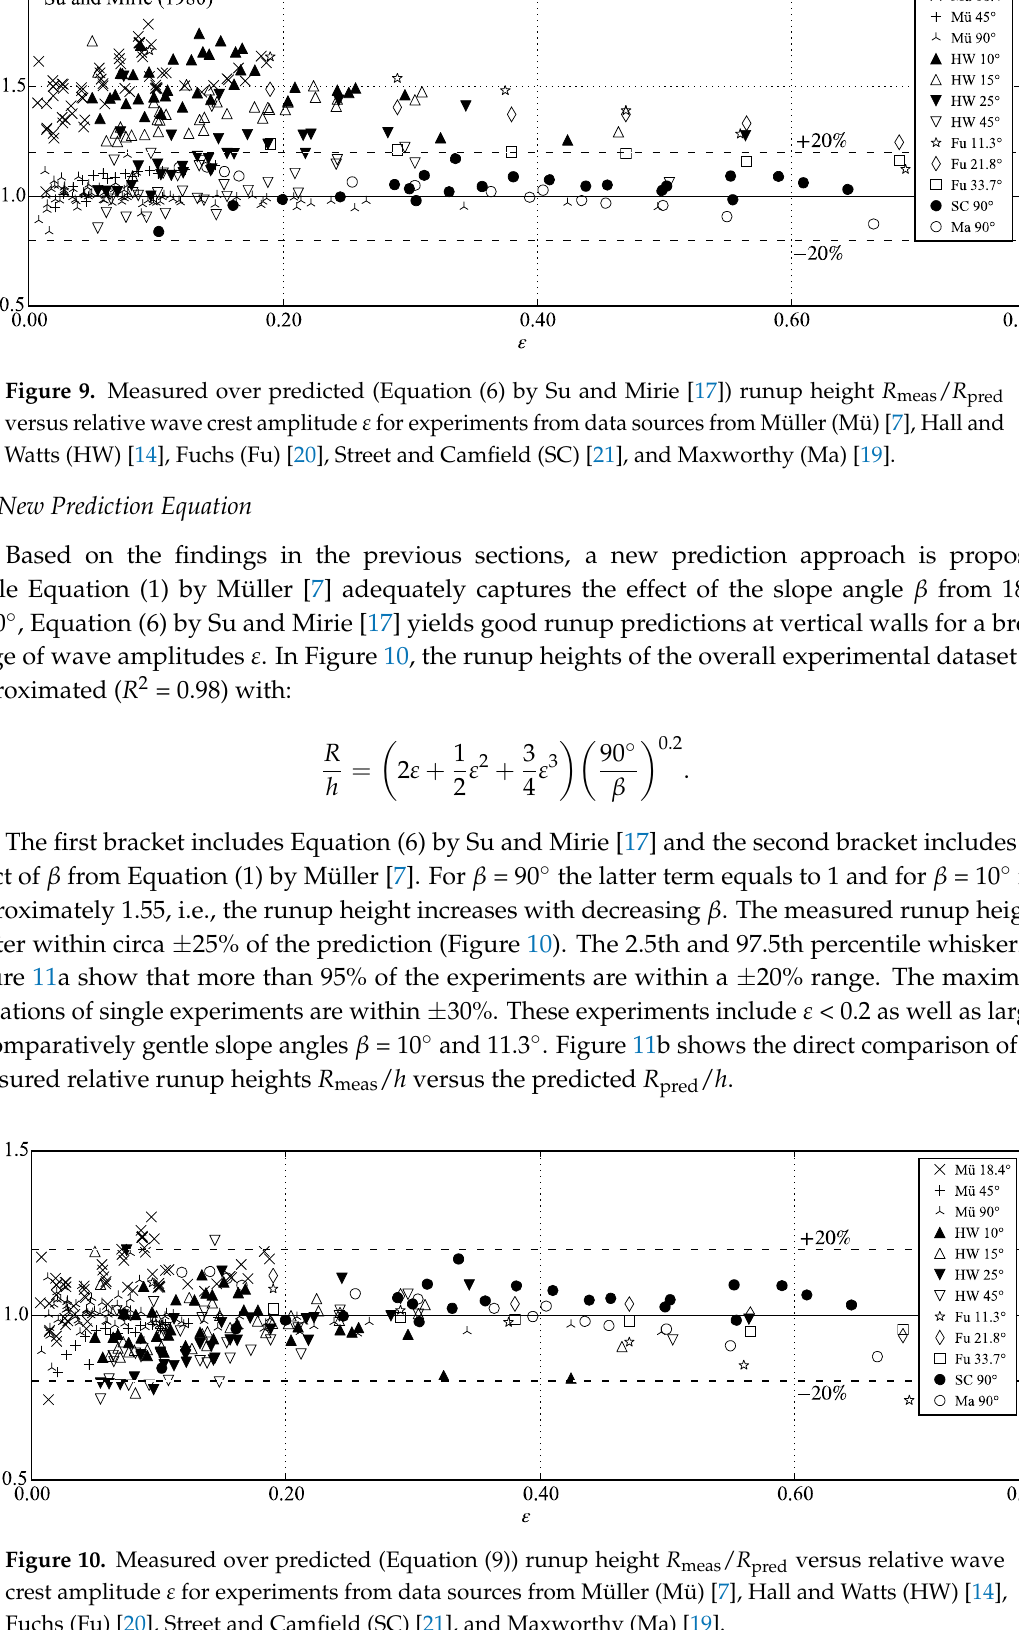
( a ) ( b ) Figure 11. ( a ) Histogram and boxplot with whiskers at 2.5th and 97.5th percentile of measured over predicted (Equation (9)) runup heights R meas / R pred and ( b ) measured versus predicted runup heights R over stillwater depth h of the overall dataset. As a simplified version of Equation (9), the following prediction equation for non‐breaking impulse and solitary wave runup on steep to vertical slopes is proposed ( R 2 = 0.98): 0.2 0.4 90 2          R e h . (10) The term 2 εe 0.4 ε in Equation (10) approximates Su and Mirie’s [17] Equation (6) by multiplying the minimum runup height of 2 ε for very small relative wave amplitudes ε with an exponential function accounting for the second‐ and third‐order effects, which become significant for large ε . 33 additional experiments are added as a validation dataset to Figure 12, including data from Pedersen et al. [27] ( n = 5; β = 10°), Li and Raichlen [28] ( n = 22; β = 25.7°), and Losada et al. [29] ( n = 6; β = 45°,